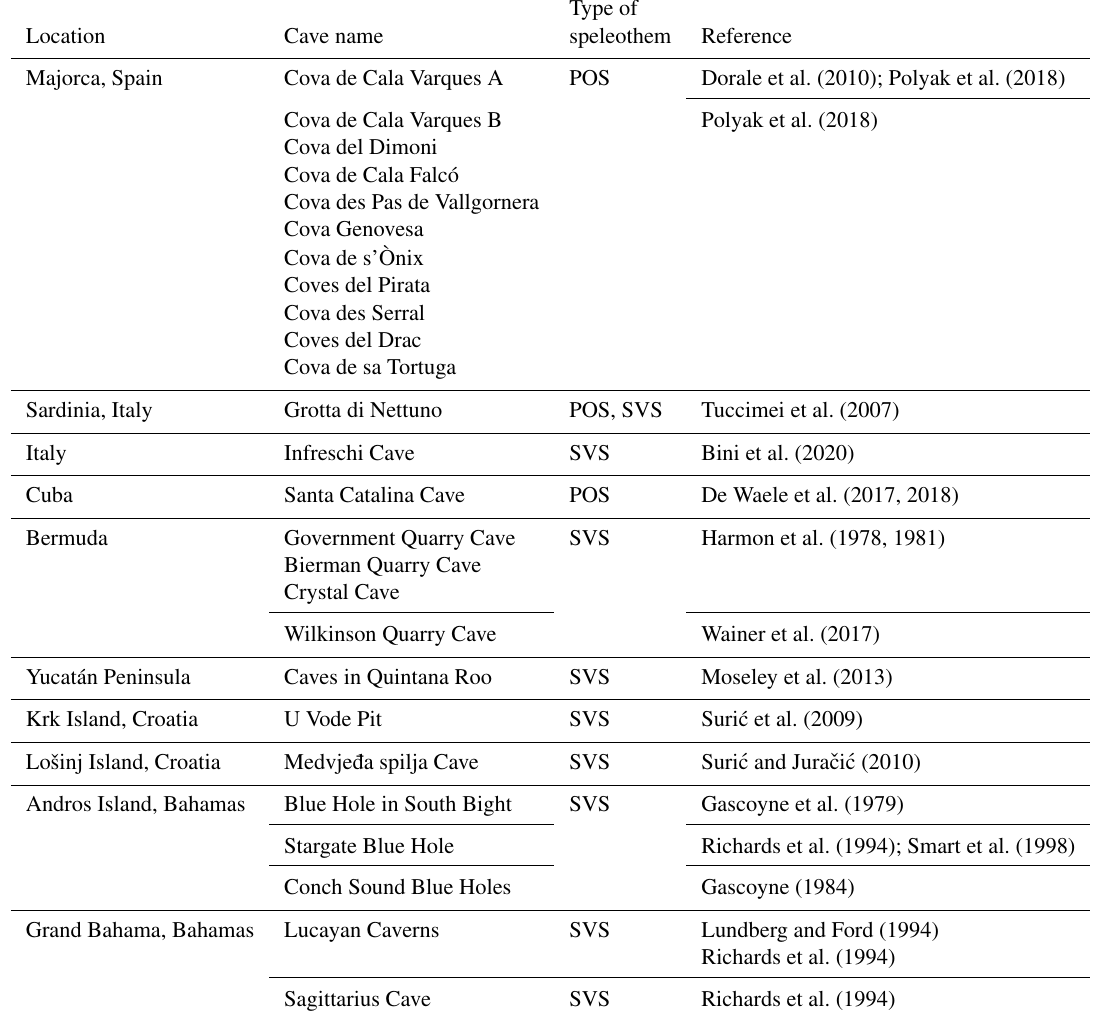
Table 1. Sites included in data product. Location and name of the caves, type of speleothems, and the corresponding